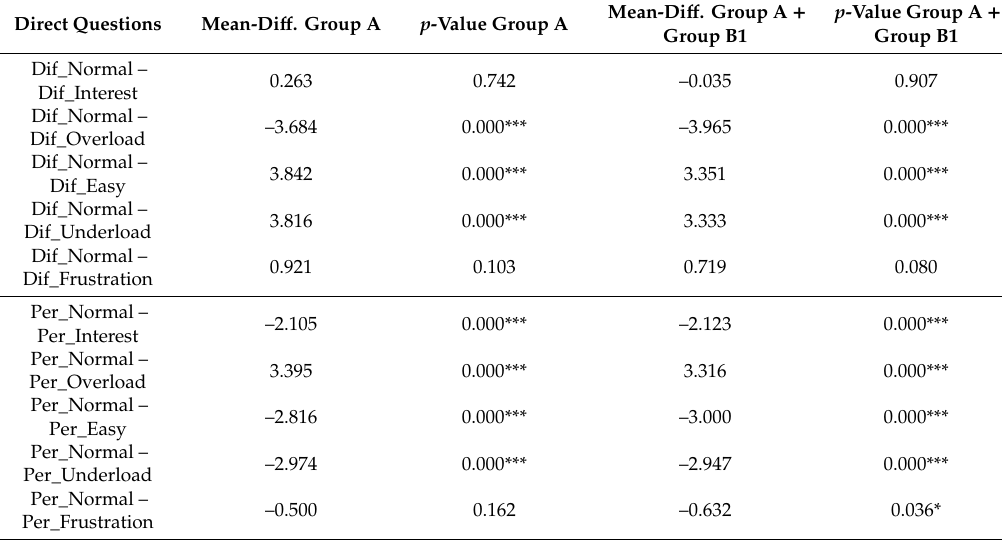
Table 5. Post-hoc Newman-Keuls corrections for the “Di ffi culty” (Dif), “Performance” (Per), “Stress” (Str) and “Motivation” (Mot) questions between all sequences compared to Normal . Mean-Di ff erences (Mean-Di ff .) and p -values are